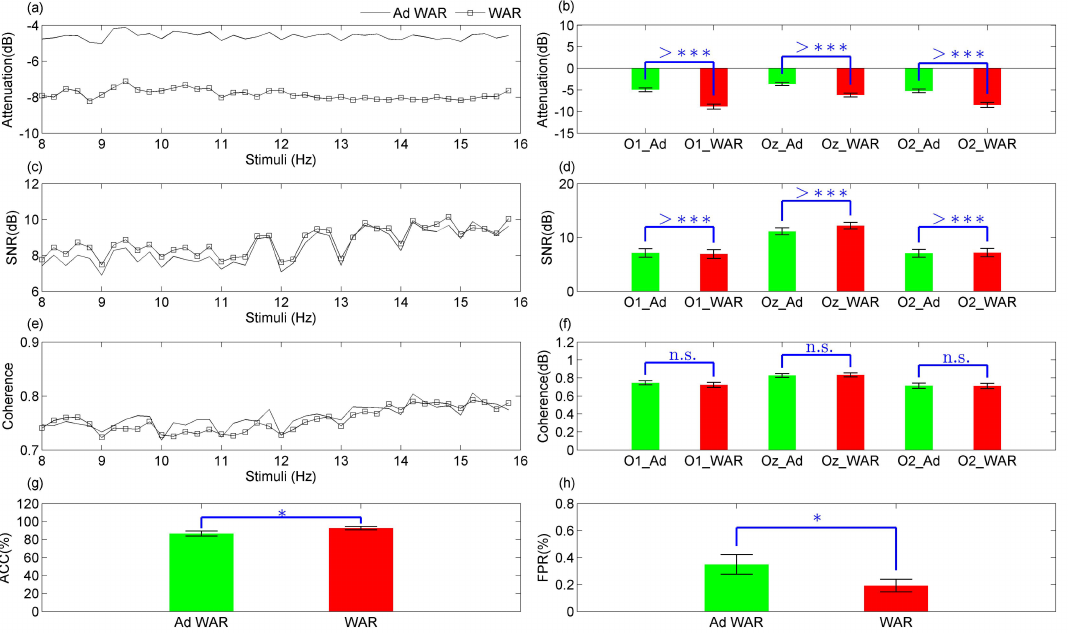
Figure 4. Comparison between the spatial filters WAR (red) and Ad WAR (green) through 40 stimuli using SSVEP. p values representation ( n . s .